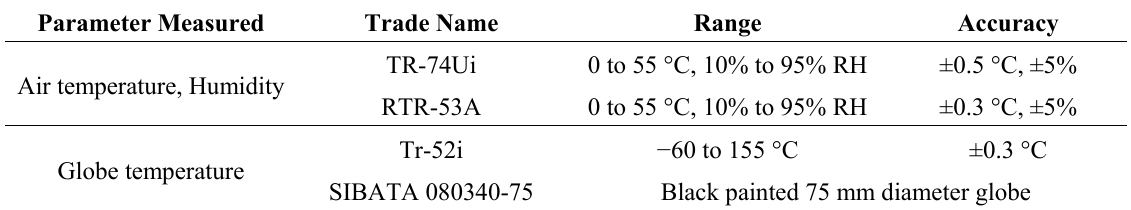
Figure 1. Measurement of indoor air temperature, globe temperature and relative humidity. Table 1. Details of the instruments used for the environmental measurement.